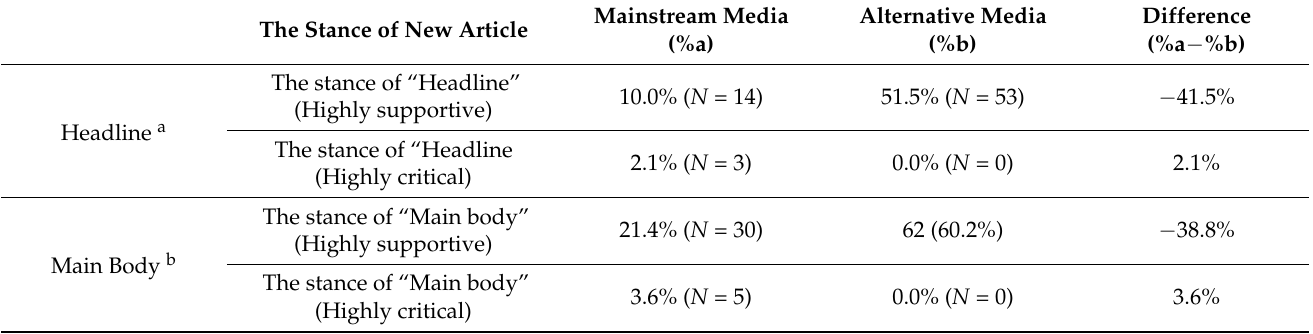
Table 3. Comparison of the stance of news between mainstream media and alternative media.